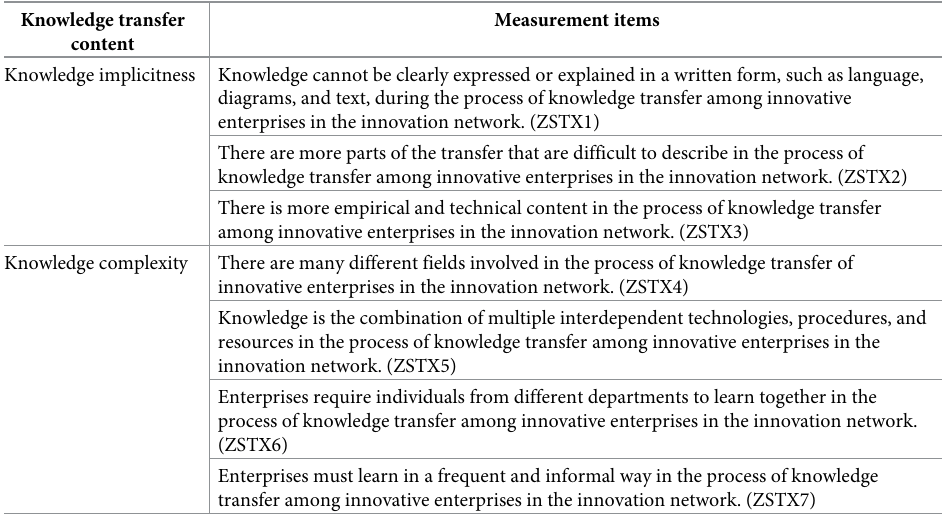
Table 3. Knowledge transfer content measurement items.